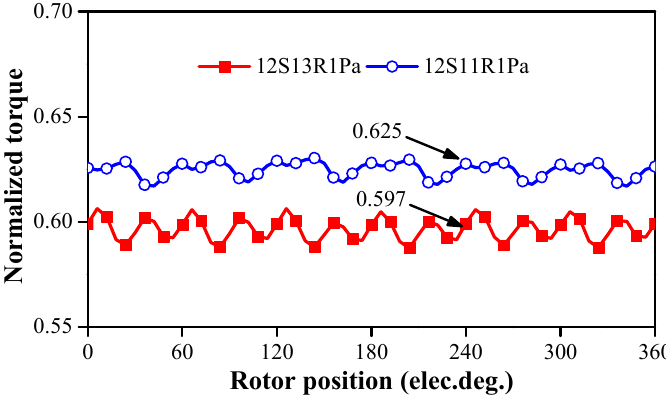
Figure 8. Twelve-stator-slot STDPM machines with a different rotor slot number. ( a ) 12S23R1Pa; ( b ) 12S25R1Pa.